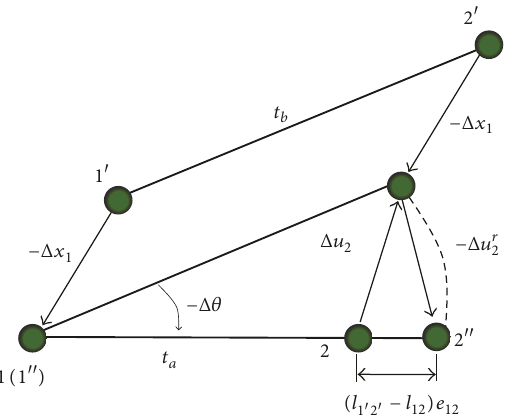
Figure 3: Reversed translation and rotation.